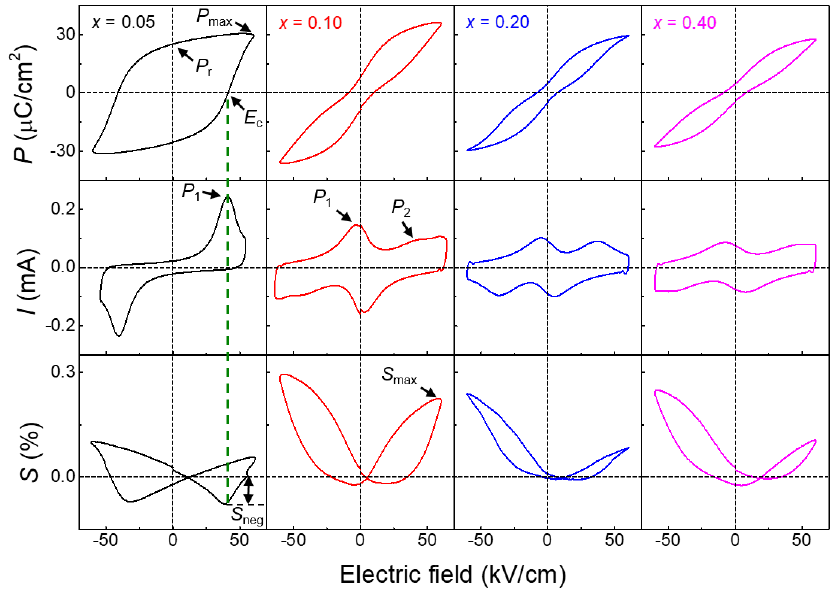
Figure 6. Polarization ( P ), current ( I ), and strain ( S ) vs. electric ( E )-field loops of BNKT ceramics ( x = 0.1, 0.2, 0.3, 0.4, and 0.8) at 60 kV/cm, frequency 10 Hz at room temperature.